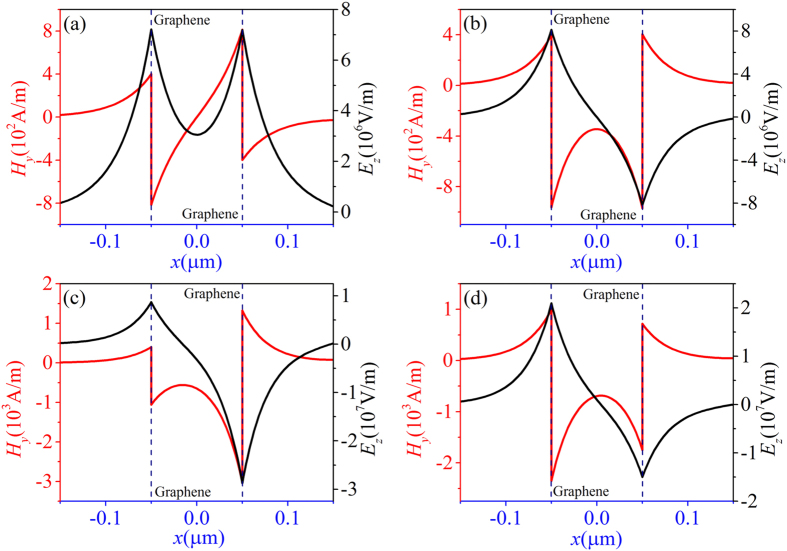
The field distribution for magnetic component Hy and electric component Ez, which correspond to points A, B, C and D in Fig. 2, respectively.(a) (H0, β) = (400A/m, 0.0779kF), (b) (H0,
β) = (400A/m, 0.0693kF), (c) (H0, β) = (400A/m, 0.0835kF), (d) (H0, β) = (1000A/m, 0.0805kF). Other parameters are the same as in Fig. 2.